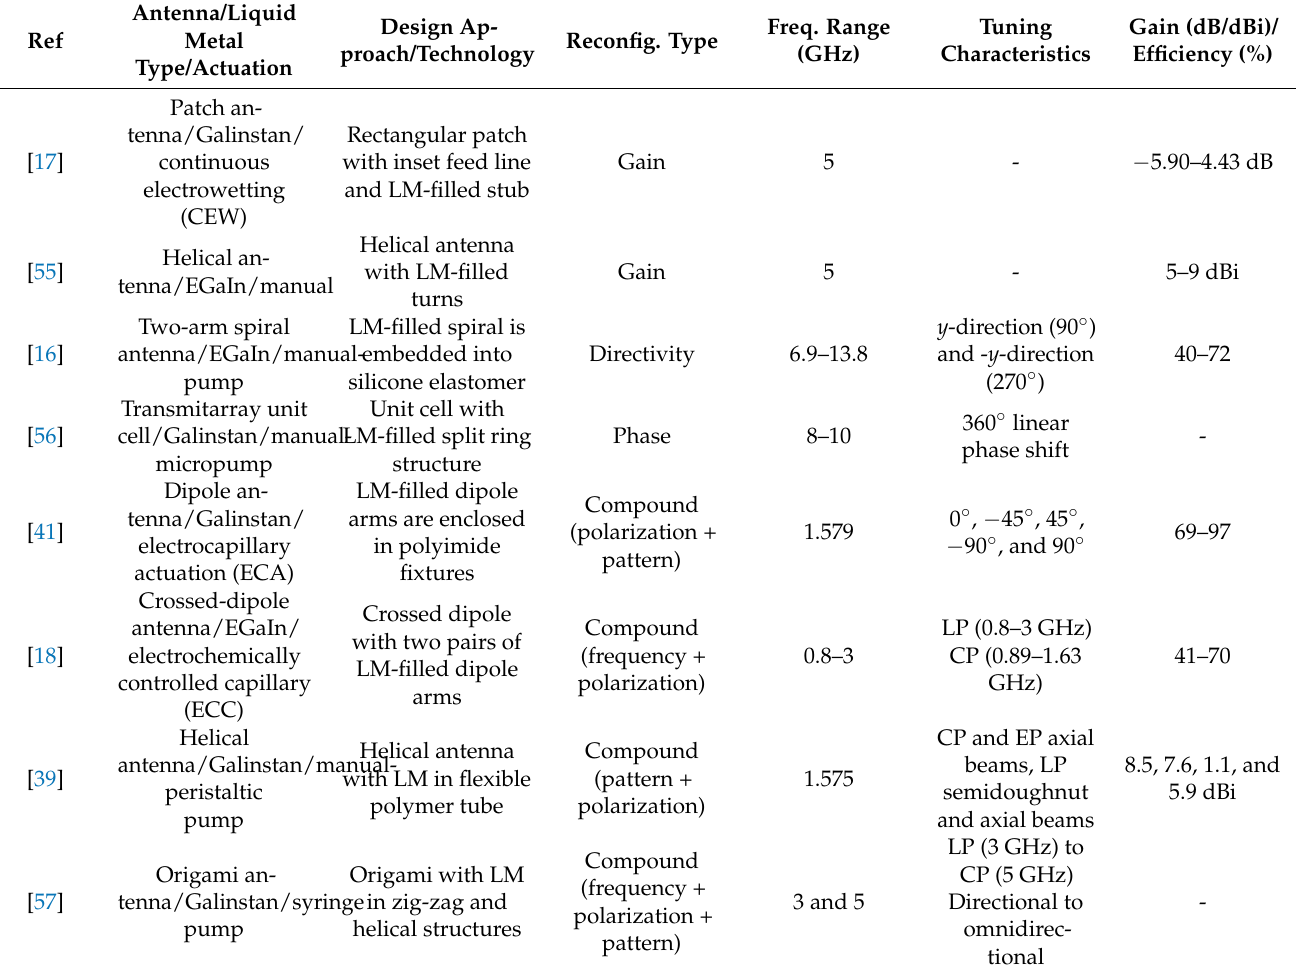
Table 4. Summary of antennas with other types of reconfiguration using nontoxic conductive liquids.